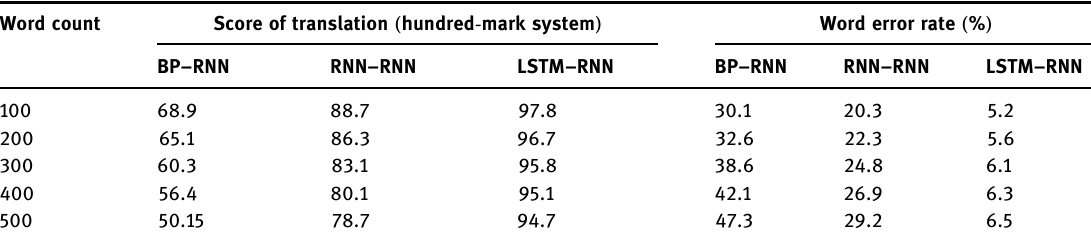
Table 3: The actual application performance of the three machine translation algorithms for English